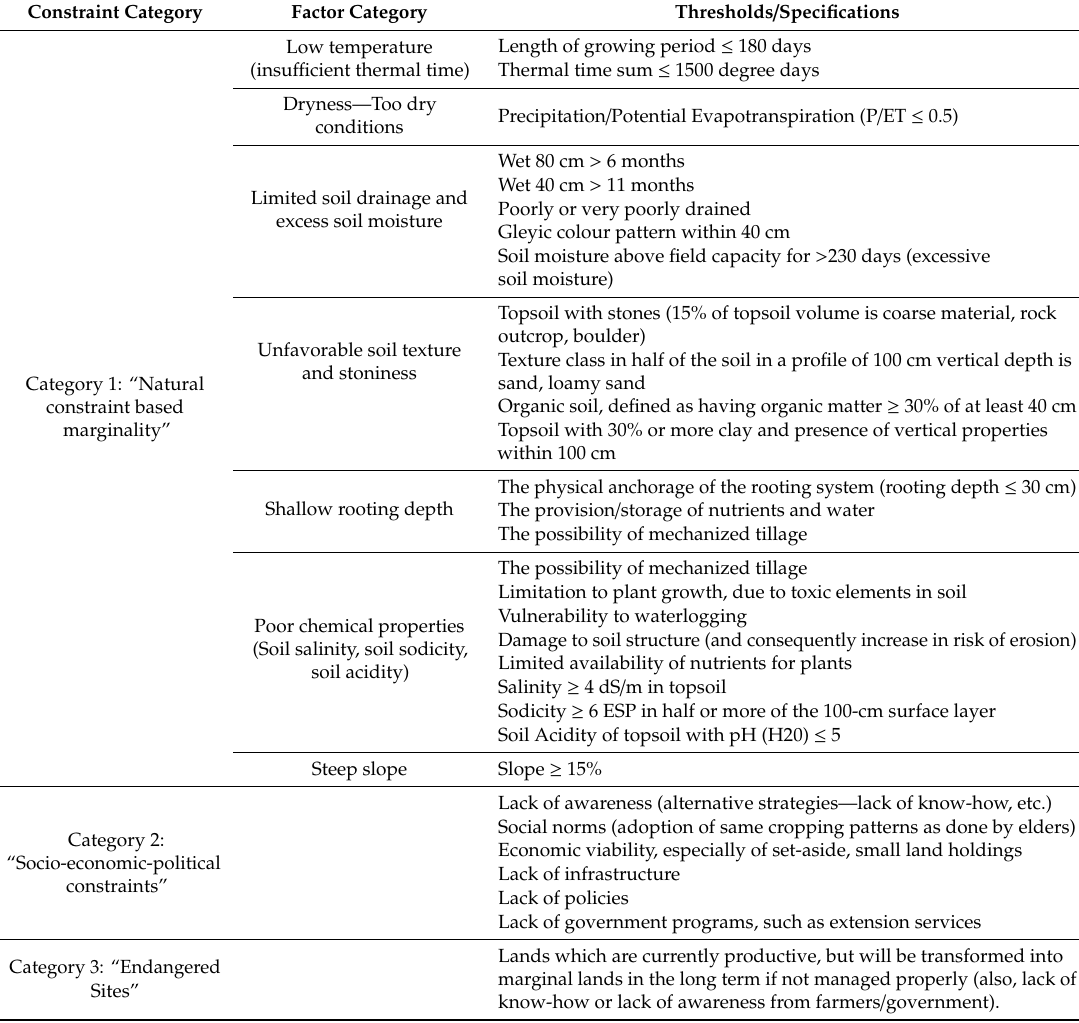
Table A1. Overview of the three categories of marginality constraints as classified within this deliverable. Category 1 was adapted from Reference [20]. Categories 2 and 3 were developed based on the literature